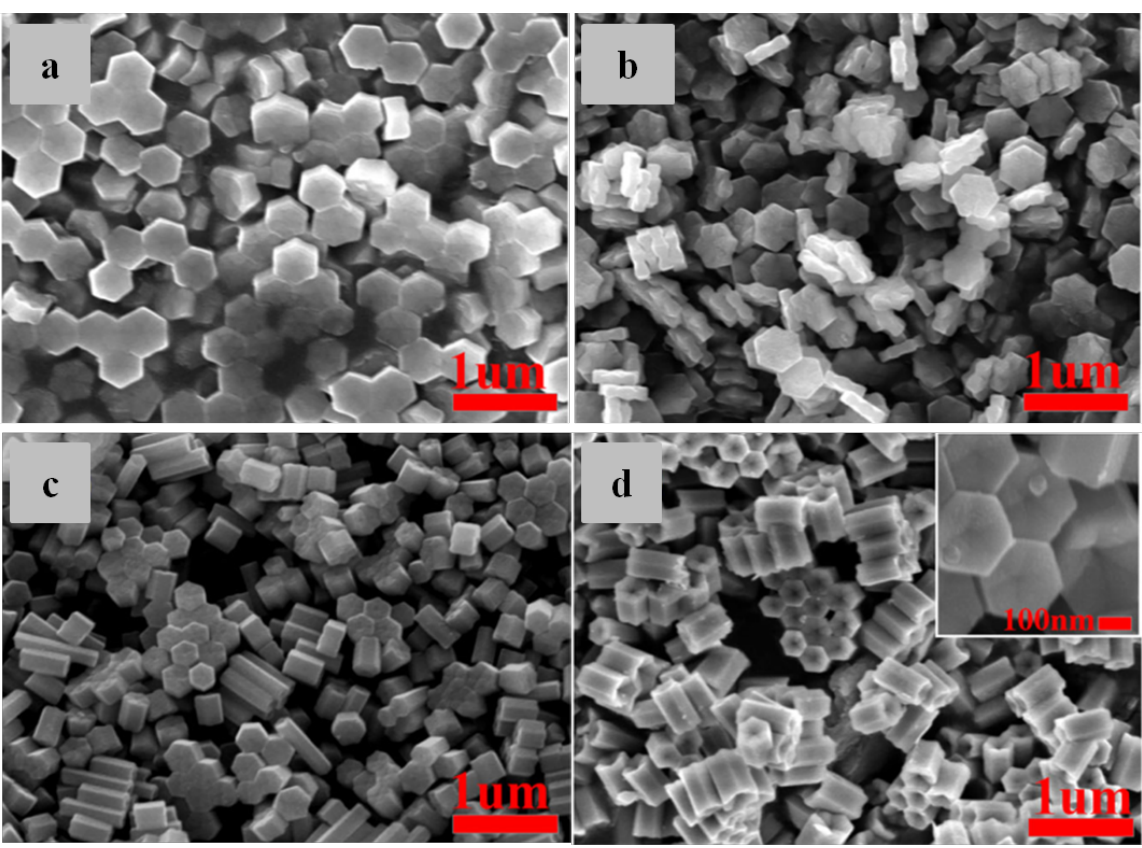
Figure 4: SEM image of the as-synthesized NaYF 4 :Yb 3+ /Er 3+ /Ni 2+ (20/2/x mol%) nanocrystals: a) x = 0, b) x = 20, c) x = 30, d) x = 40 [32].